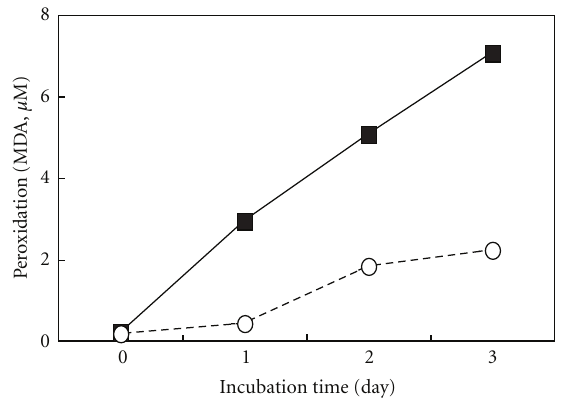
Figure 1: Peroxidation of EPA/DHA. EPA (open circles) and DHA (closed squares) were incubated under the air at 37 ◦ C for the indicated times. Peroxidation levels of EPA/DHA were measured by TBARS assay, and were expressed as MDA concentration equivalent per EPA/DHA (500 μ M). Data are means of 3